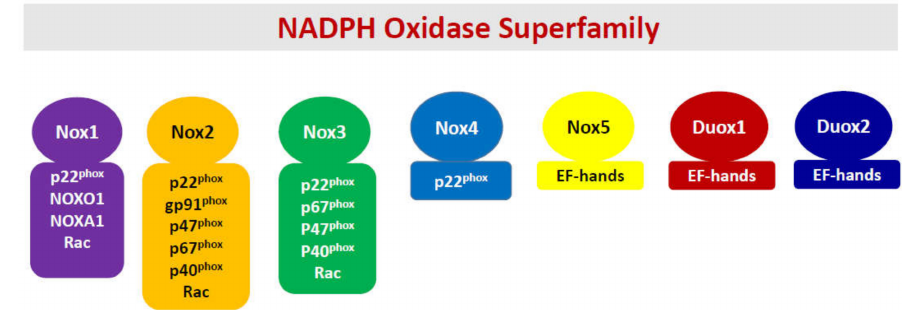
Figure 1. A schematic representation of various members and their subunit composition of the Nox